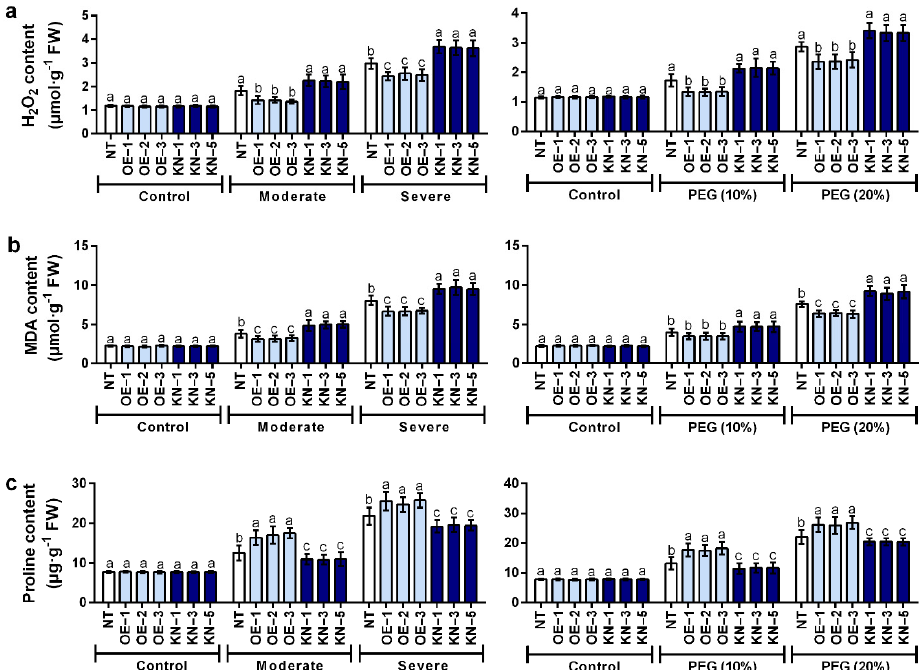
Figure 7. Activity of CAT, SOD and POD increased by water deficiency and osmotic stress is positively regulated by StCDPK28 overexpression. Activity of ( a ) CAT, ( b ) SOD and ( c ) POD was examined 24 h after potato plants were treated by water deficiency and PEG. Data are presented as the means ± standard deviation of nine replicates. The letters indicate significant difference according to one-way ANOVA corrected by Dunnett ( p < 0.05).